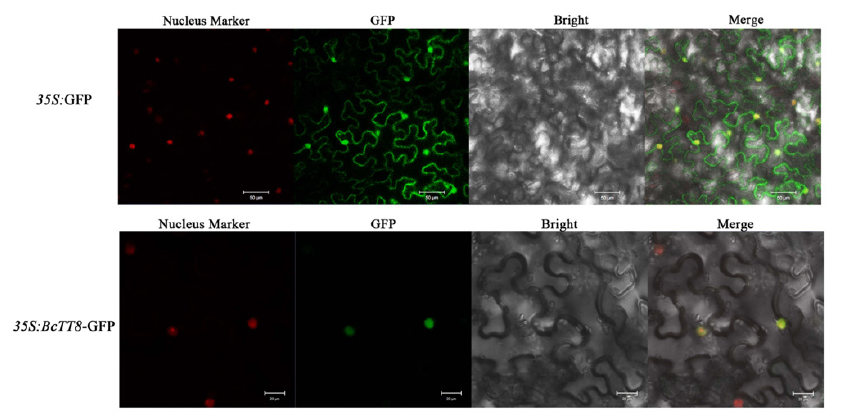
Figure 6. Subcellular localization of 35S :GFP and 35S : BcTT8 -GFP, bars = 20 µ m, 35S :GFP was used as a control.